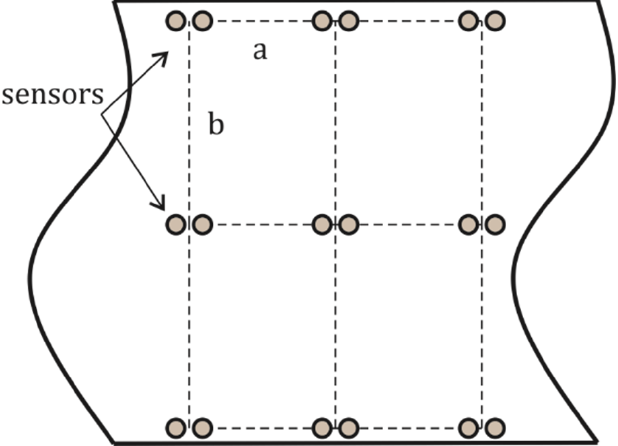
Figure 6. The sensor array for baseline-free damage diagnosis—a and b correspond to the horizontal and vertical distances between the sensor pairs, respectively.